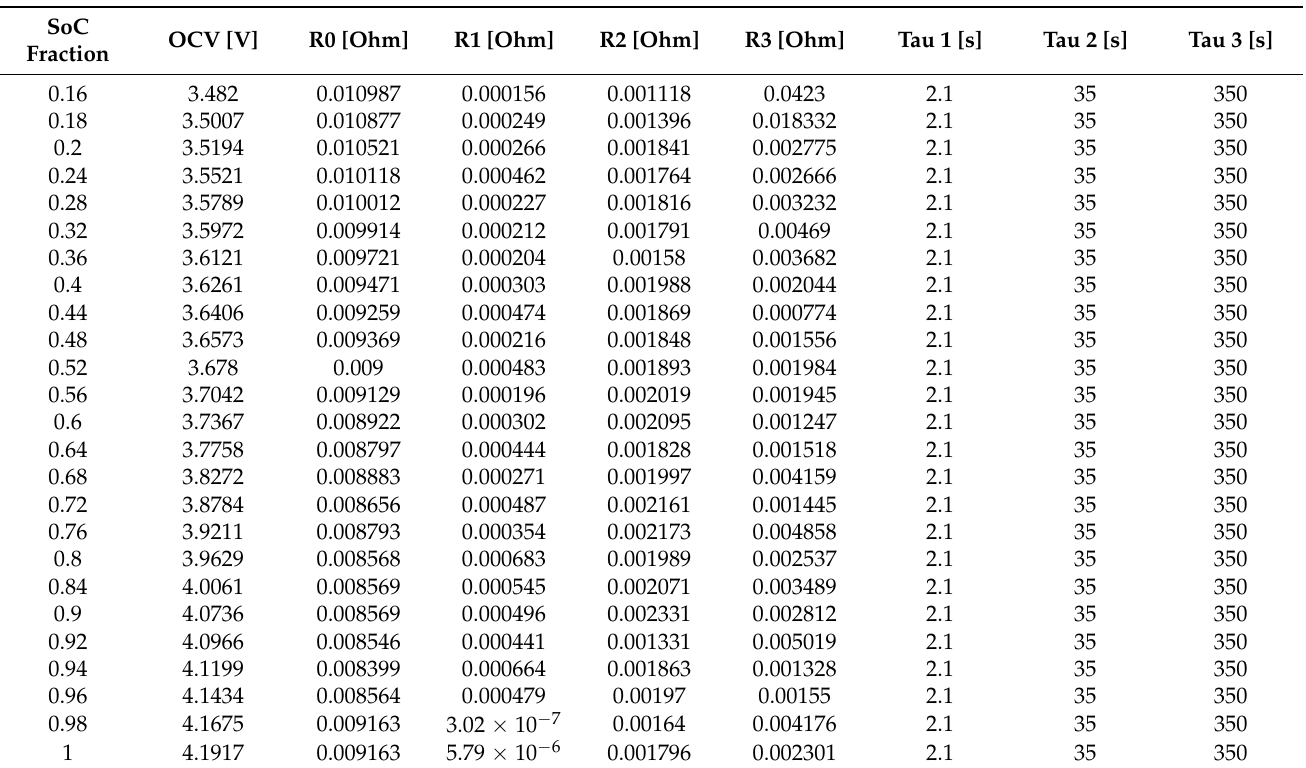
Table A6. ECM results from AMPP in the ICP at 25 ◦